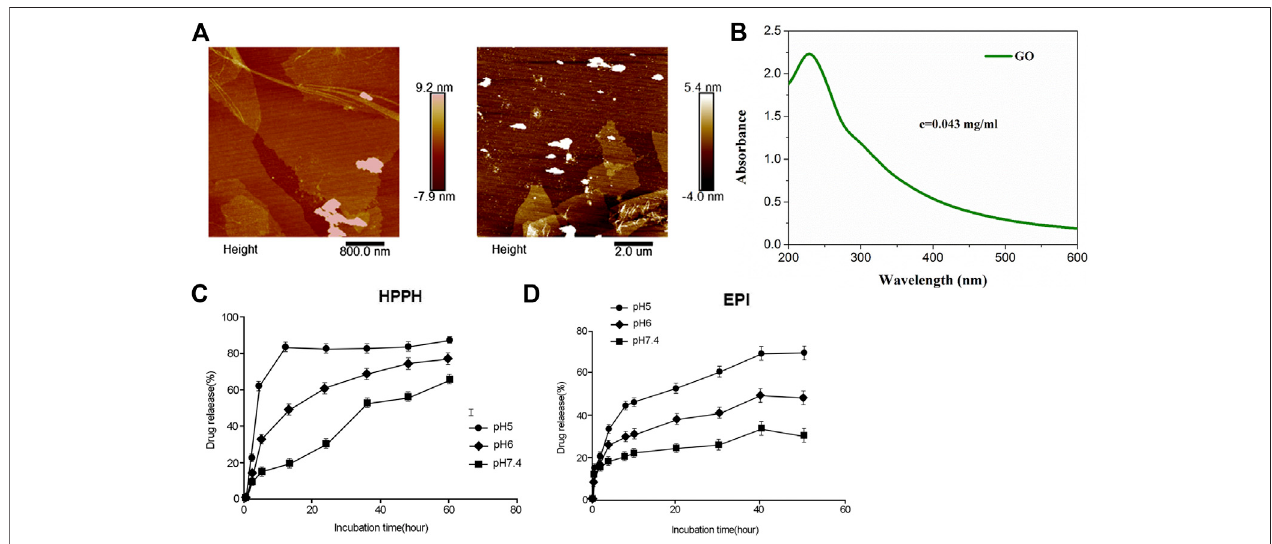
FIGURE 1 | Characterization and in vitro drug release of HPPH/EPI/CPP-pGO. (A) The representative images of GO using atomic force microscopy. (B) The ultraviolet visible absorption spectra of GO. (C) Cumulative HPPH release pro fi ling of HPPH/EPI/CPP-pGO in phosphate-buffer saline (PBS, pH 7.4, 6.0, and 5.0).